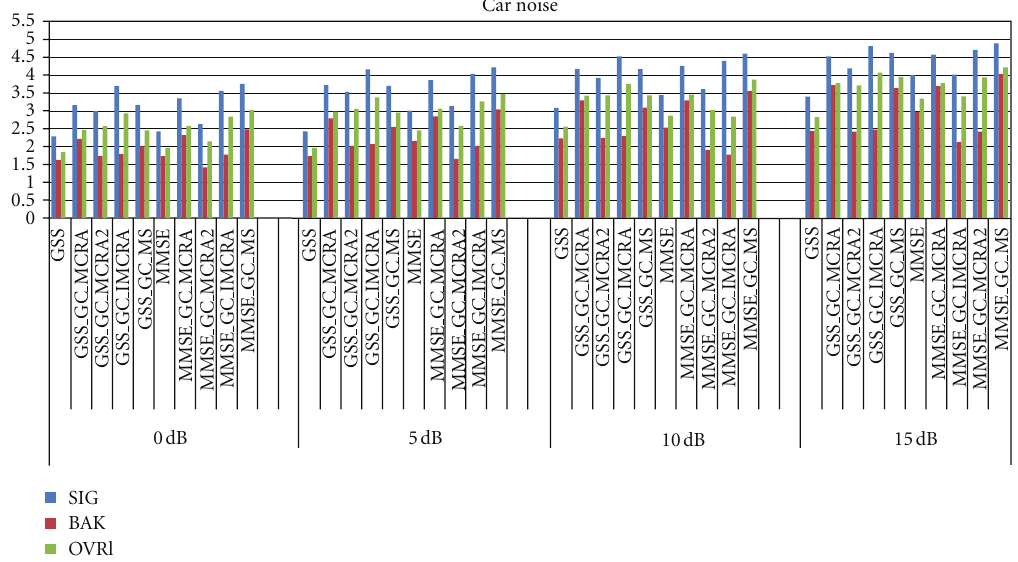
Figure 9: SIG-BAK-OVRL scores for proposed speech enhancement with the gammachirp decomposition compared to the GSS and the MMSE at di ff erent SNR input for car